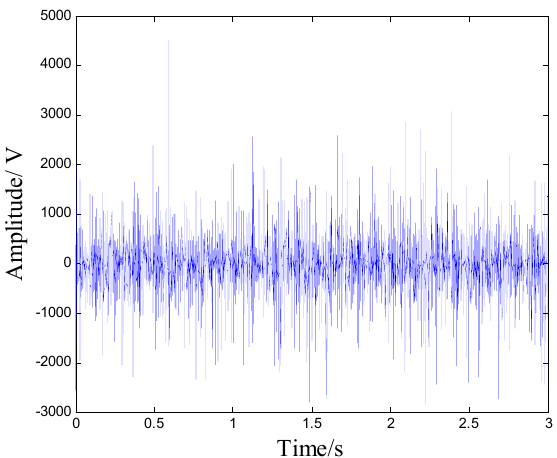
Figure 33. The time domain plot of circular pitch error gear.